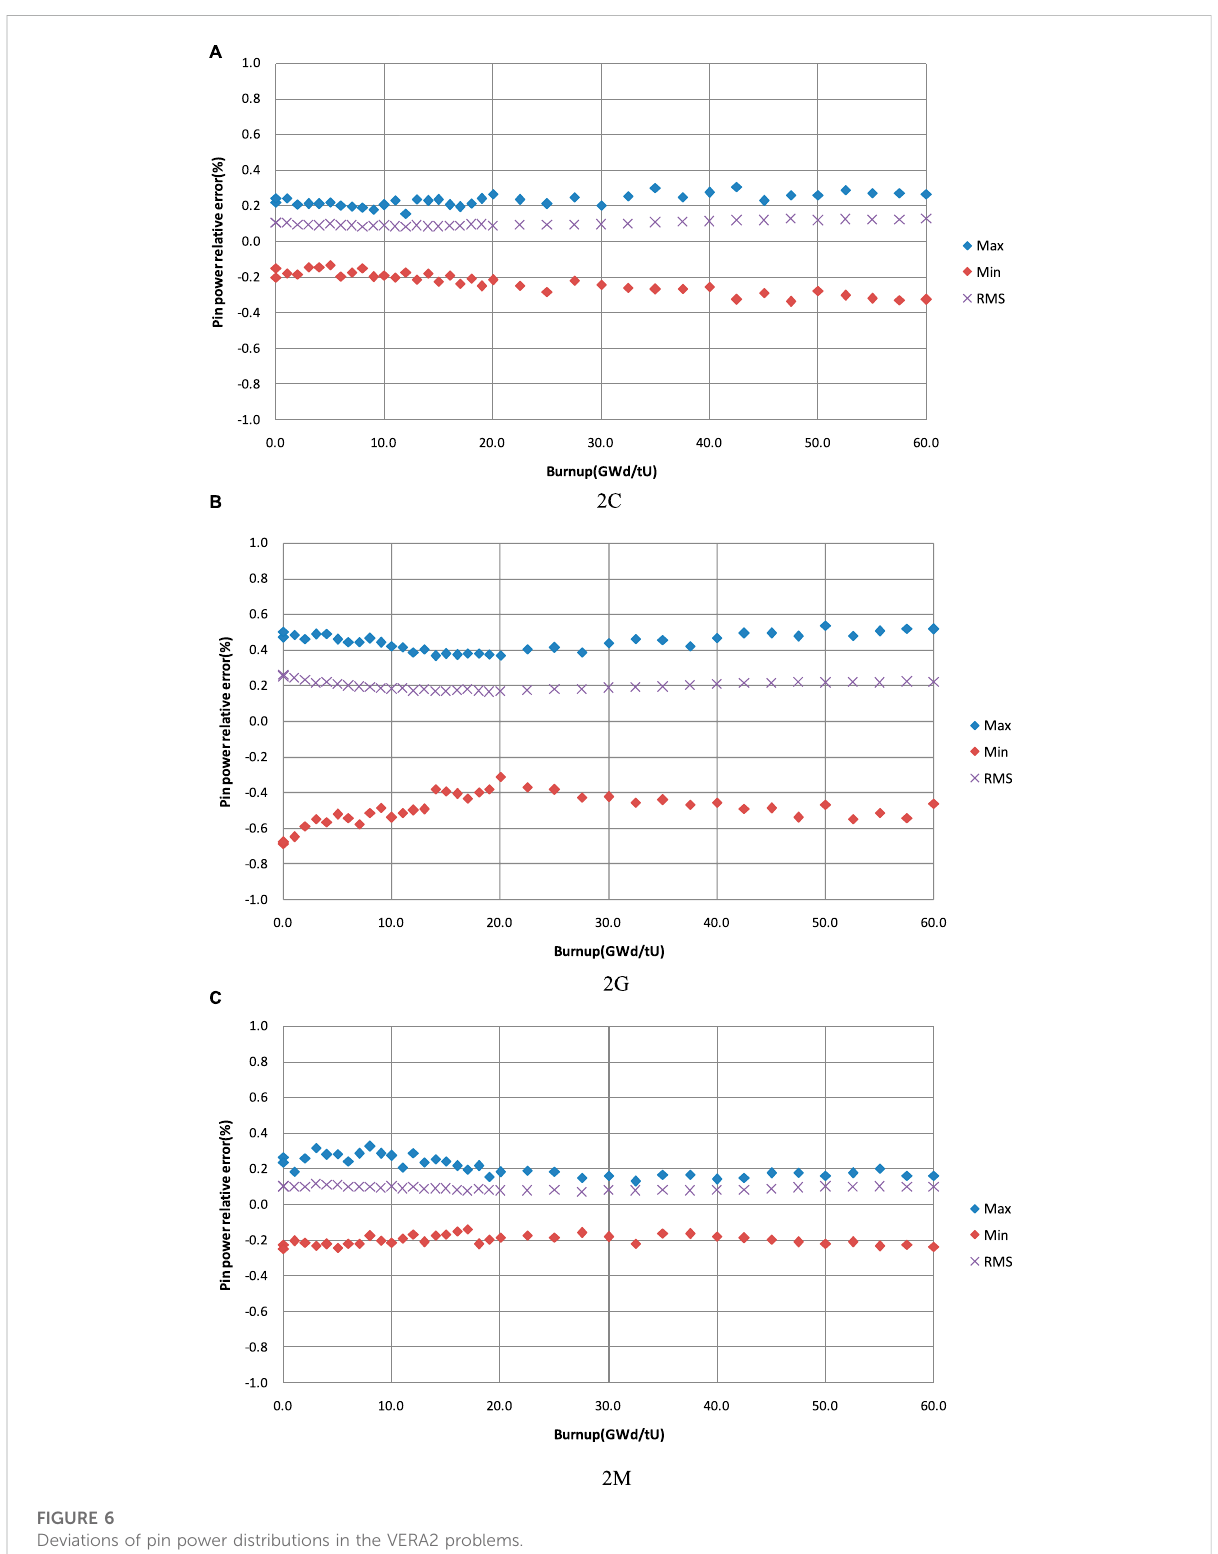
FIGURE 6 Deviations of pin power distributions in the VERA2